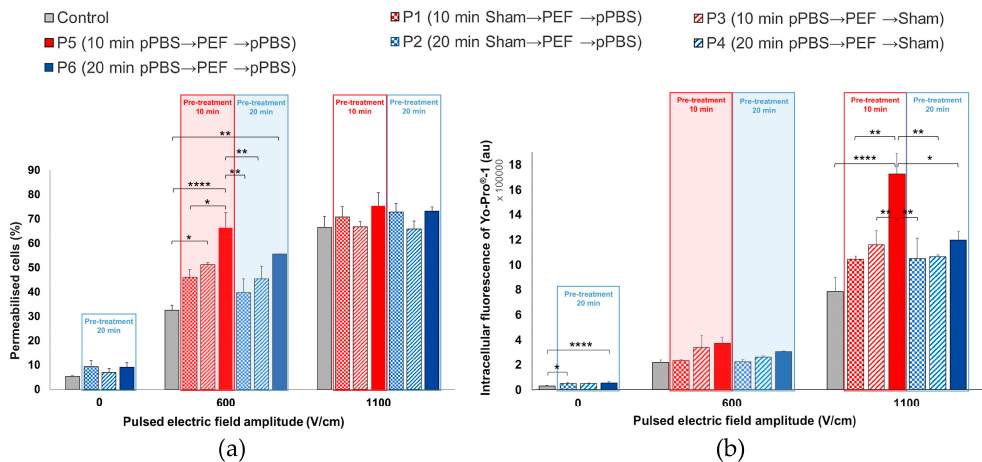
Figure 4. Schematic illustration of the protocols applied in the combined treatments, with µsPEF at 0, 500, 600, 1100 or 1400 V/cm. 500, 600, 1100 or 1400 V / cm. Cancers 2020 , 1 , x